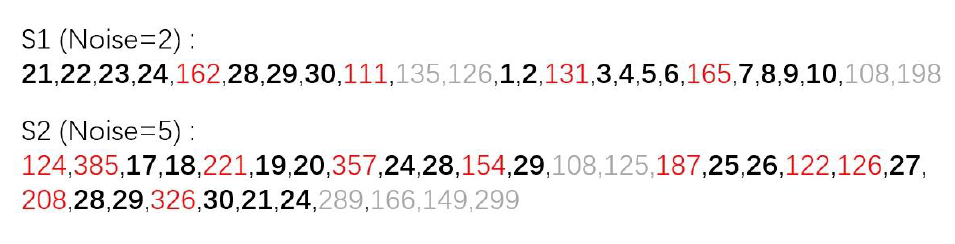
Figure 6. The generated action sequences with different noise level. The bolded numbers denote the pattern action, the grey numbers denote the background traffic, and the red numbers denote the noise actions.